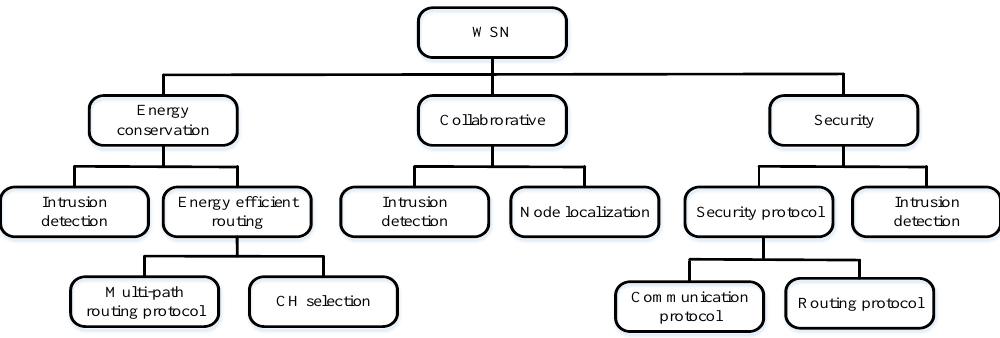
Figure 5. Main problems in WSNs.